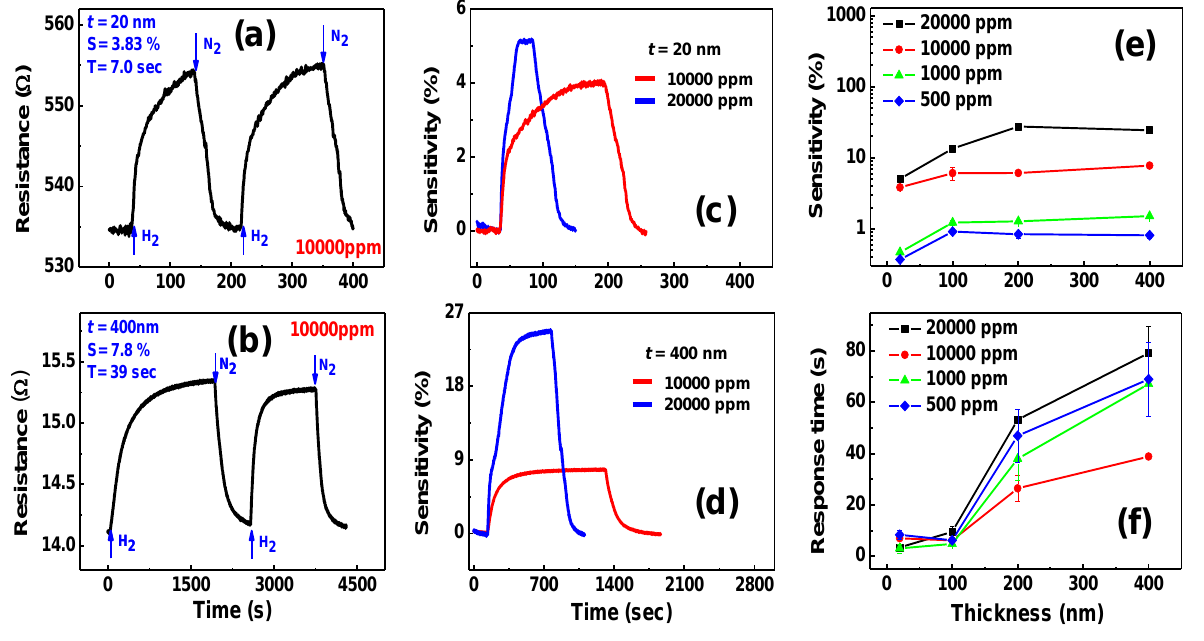
Figure 9. The real-time electrical responses of lithographically patterned Pd nanowires with (a) t = 20 nm and (b) t = 400 nm to 10000 ppm of H Sensitivities upon exposure to 10,000 and 20,000 ppm of H (c) t = 20 nm and (d) t = 400 nm. (e) Sensitivity and (f) response time as a function of the thickness of lithographically patterned Pd nanowires in the H to 20,000 ppm. Data reproduced from Jeon et al .